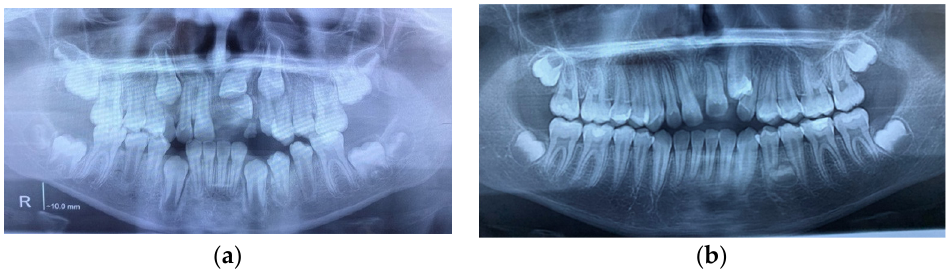
Figure 3. ( a ) Impacted upper left central incisor blocked by a DC surrounding its crown and a su- pernumerary tooth. ( b ) Abnormal shape of the canine, root DL of the upper left central incisor, and a new tooth bud developing in the lower arch. a new tooth bud developing in the lower